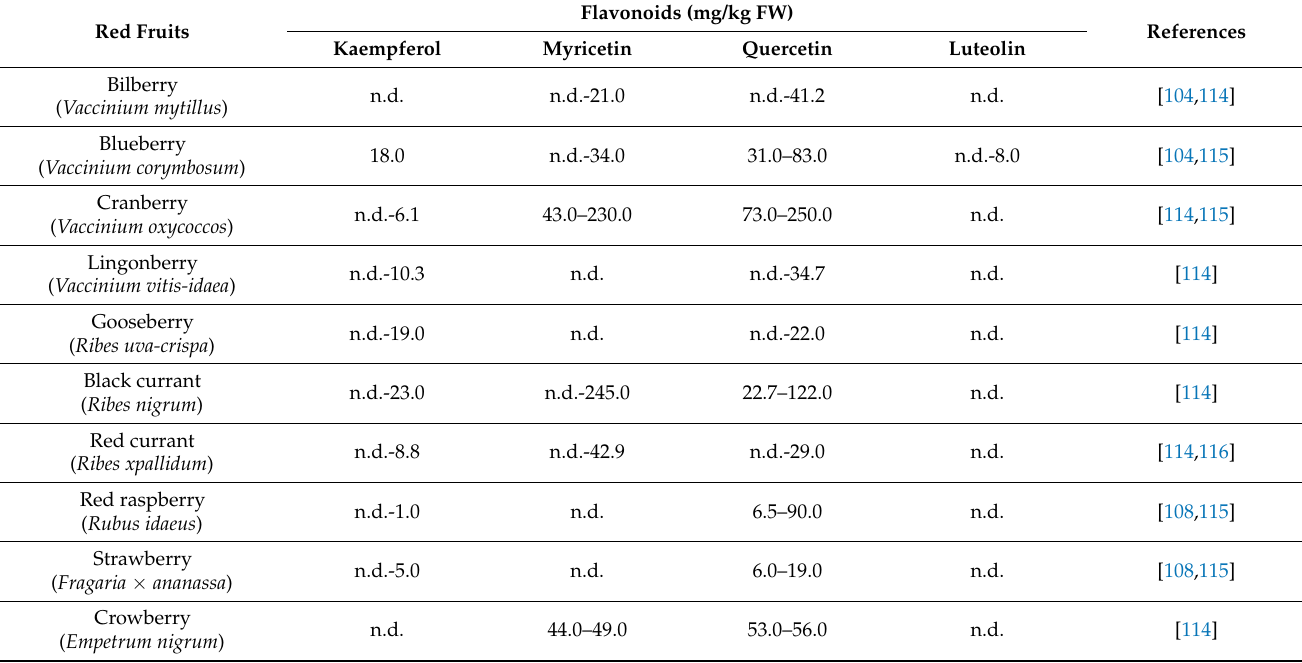
Table 9. Example of flavonoid contents found in the most common red fruits.